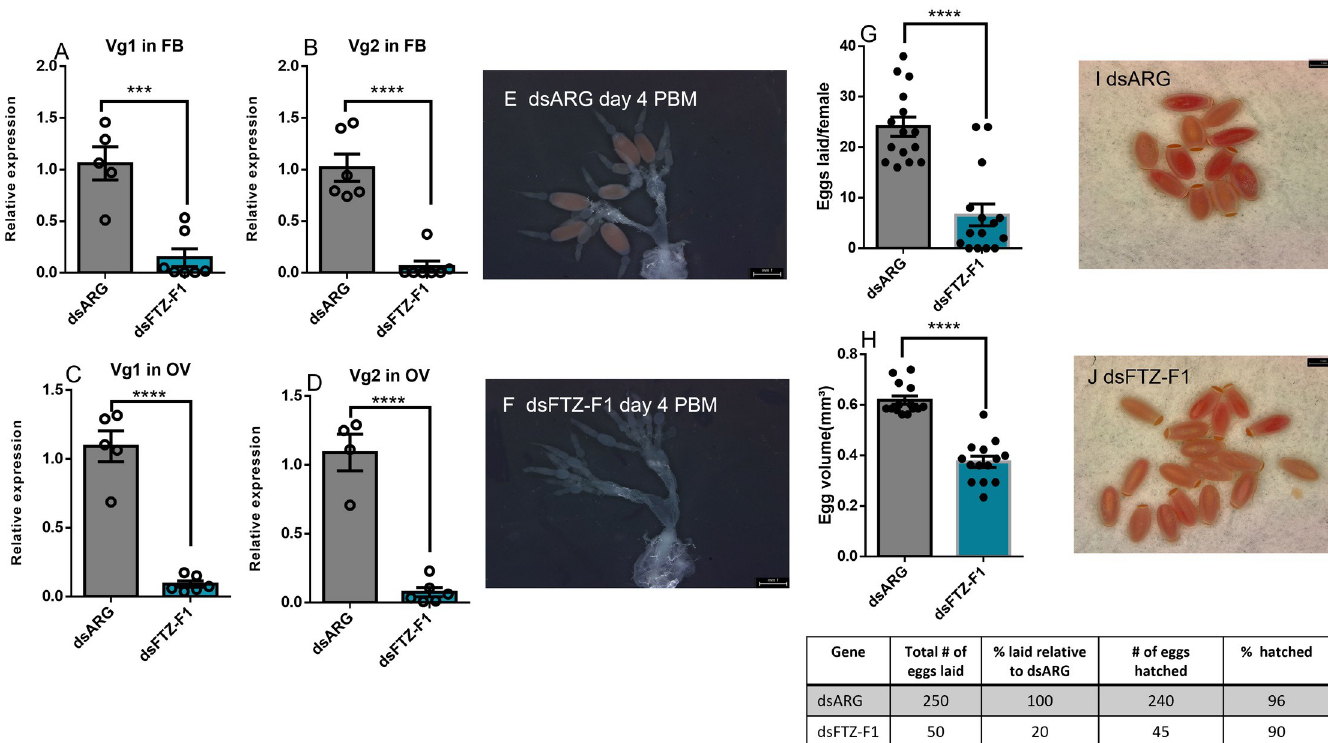
Fig 10. Effect knockdown of FTZ-F1 mRNA in adult females on egg production. RT-qPCR was used to quantify the relative transcript levels of Vg1 and Vg2 in fat body and ovary at 4 d post blood meal in dsARG (control) and dsFTZ-F1-injected females. Vg1 in FB (A), Vg2 in FB (B), Vg1 in ovary (C), and Vg2 in ovary (D). dsFTZ-F1-injection affects ovarian phenotype in comparison to dsARG-injected insects (control) (E and F) (n = 4). Eggs laid per female over 15 days PBM (G) (n = 15) and egg volume (H) (n = 15). Phenotypes of laid eggs from insects injected with dsARG (I) and insects injected with dsFTZ-F1 (J-K) (n = 15). At 4 days PBM, ovaries were dissected, and images were taken. Rp49 and β -actin were used as reference genes. The transcript levels were quantified using RT-qPCR and analyzed using the 2 − ΔΔ Ct method. Results are presented as mean ± SEM. Student’s t-test was used for statistical analysis. ��� p < 0.001, ���� p < 0. 0001.